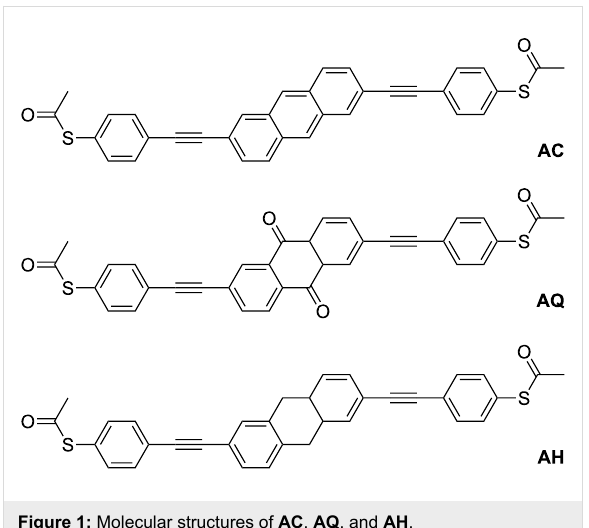
Figure 1: Molecular structures of AC , AQ , and AH